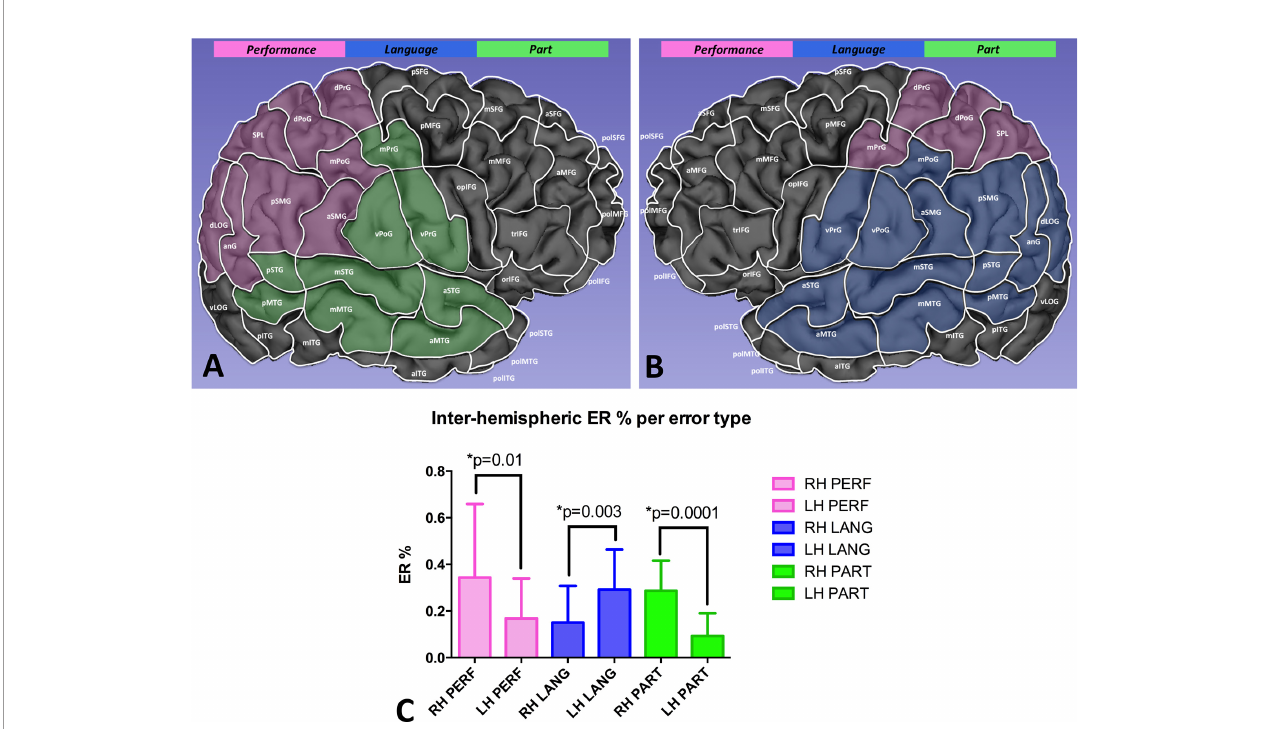
FIGURE 4 | Comparison of the ER per error type between the right (A) and the left hemisphere (B) . Performance and part errors were signi fi cantly more frequent in the right hemisphere, while language-based errors occurred more frequently in the left hemisphere (C)